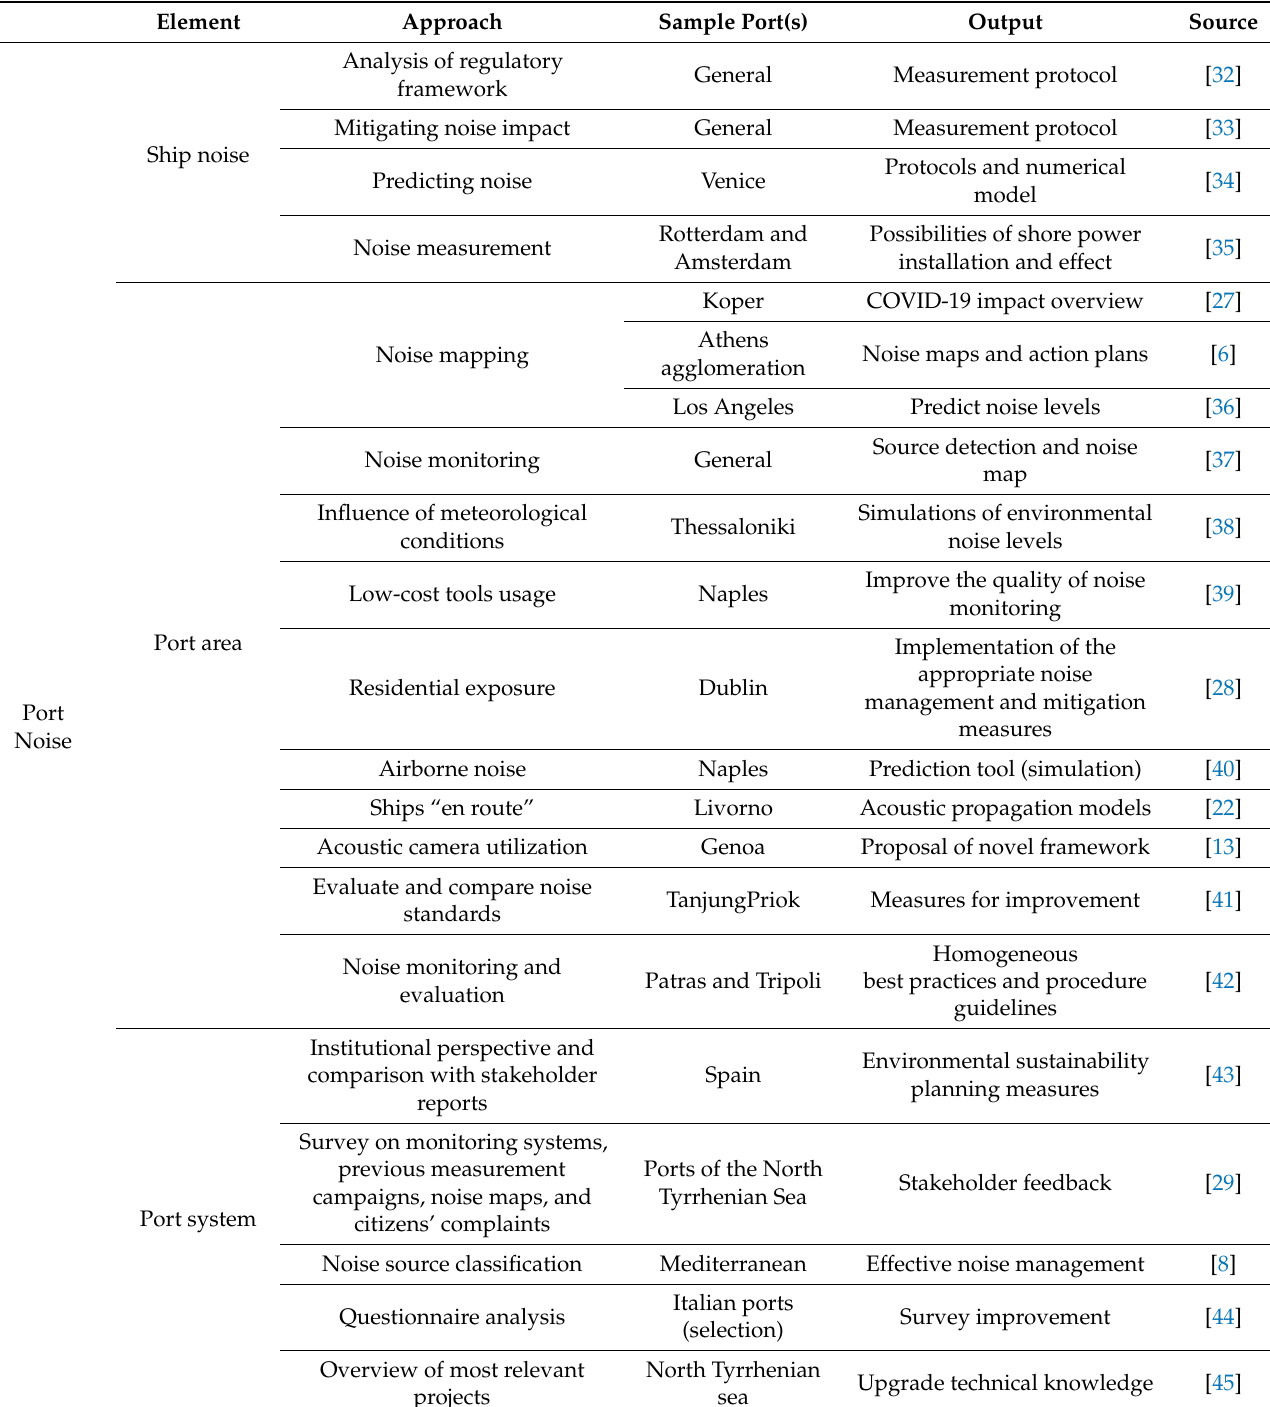
Table 1. Literature